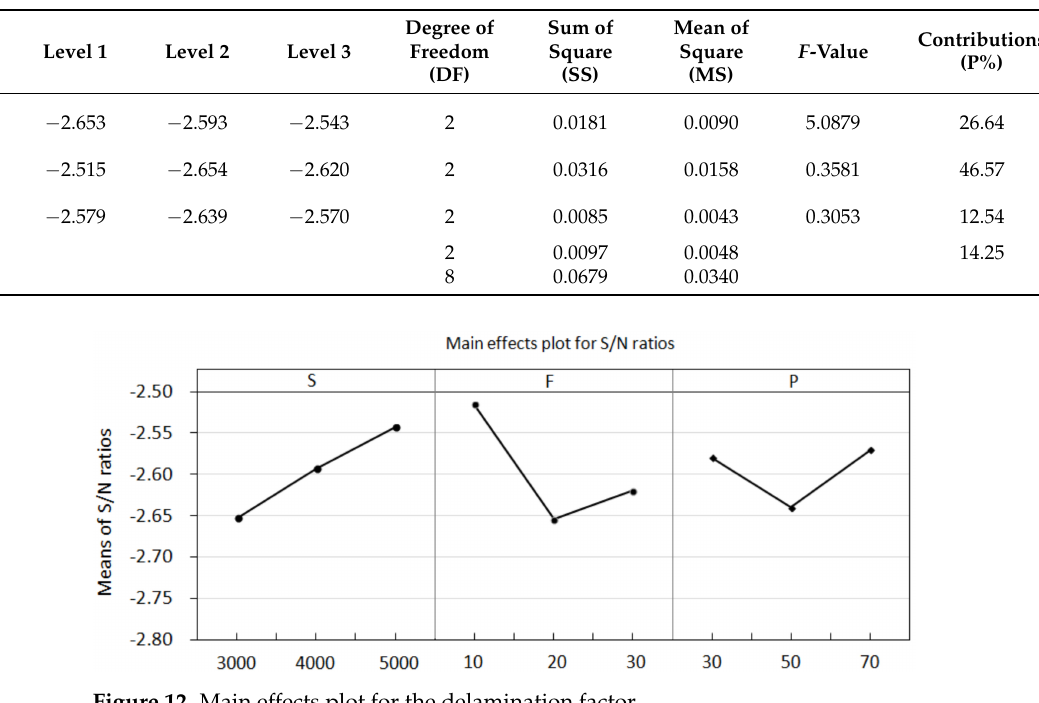
Figure 12. Main effects plot for the delamination